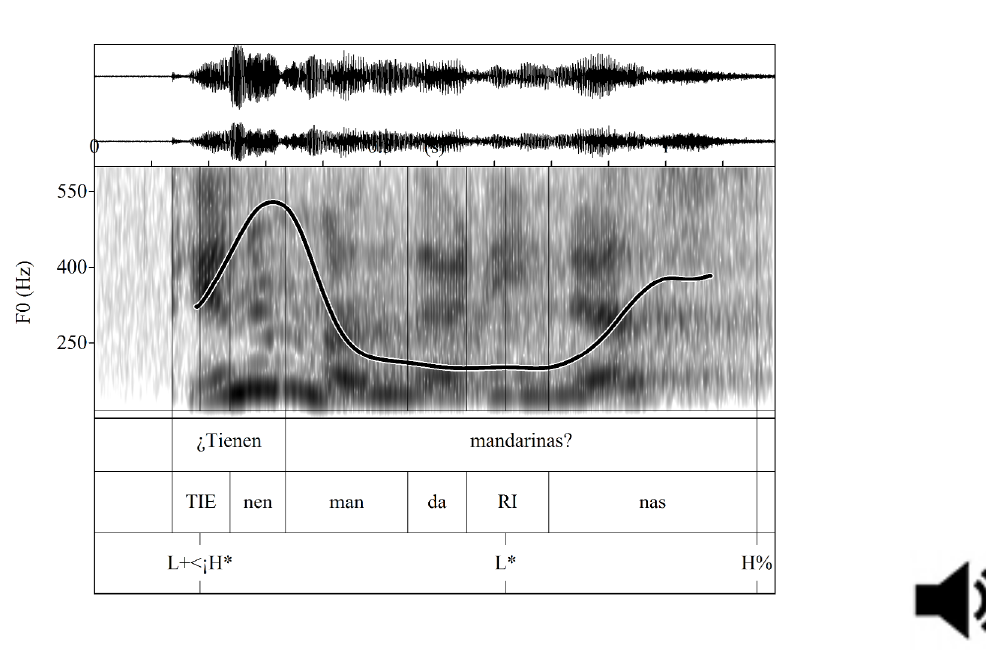
Figure 5 (Participant 12): Waveform and F0 trace for the info seeking yes-no question ¿ Tienen mandarinas? ‘Do you have tan- gerines?’ produced with L+<¡H * in pre-nuclear position and L* in nuclear position followed by an H% boundary tone.